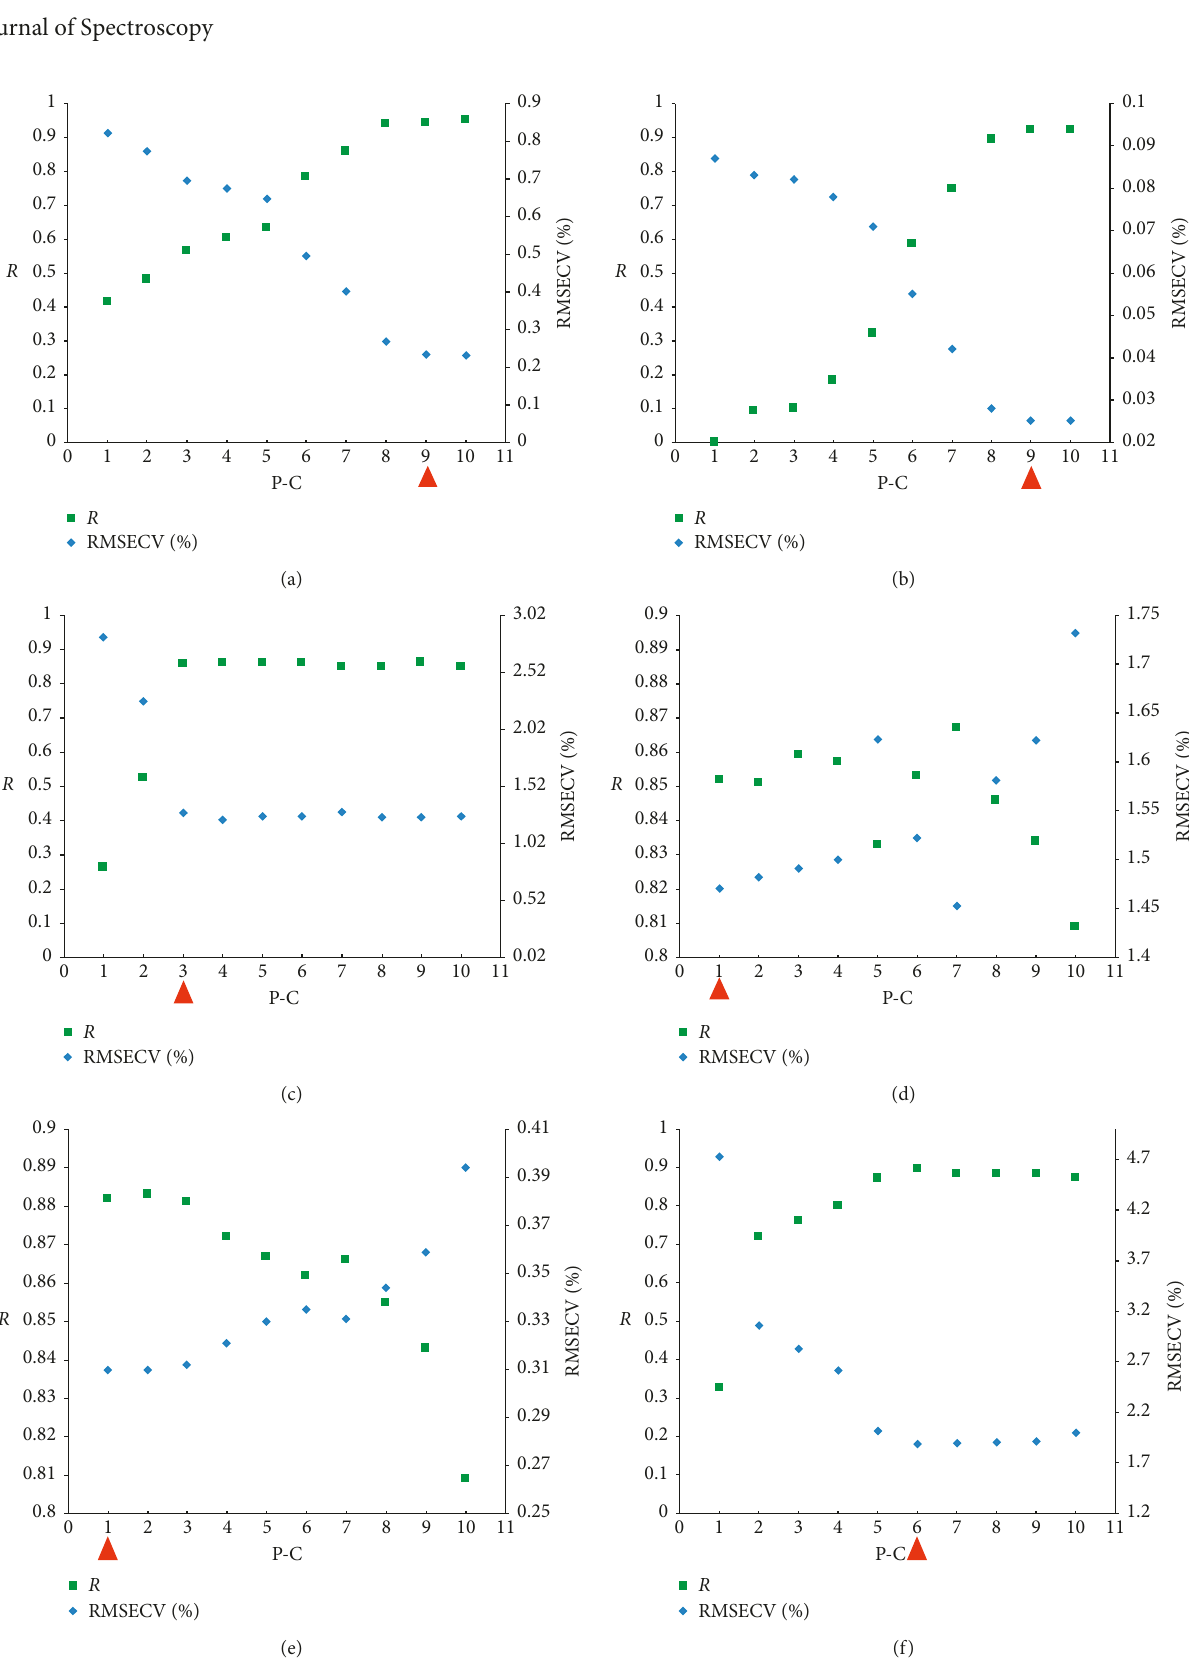
Figure 2: Relationship between principal component number and R/RMSECV of the prediction